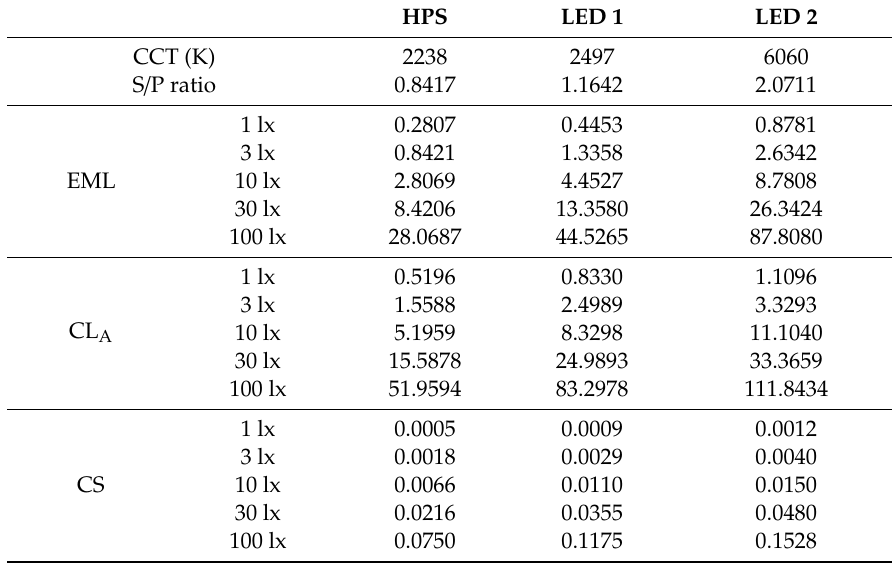
Table 1. The EML, CL A, and CS of HPS and the low CCT LED and high CCT LED at di ff erent photopic adaptation illuminance levels. HPS LED 1 LED 2 CCT (K) 2238 2497 6060 S / P ratio